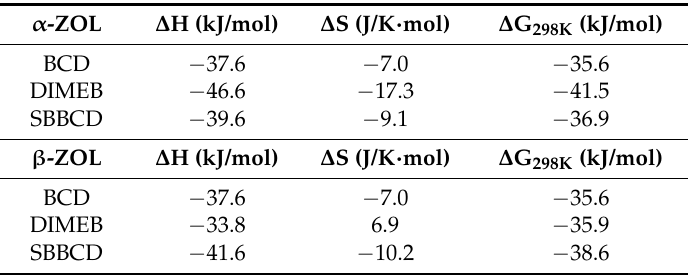
Table 4. Thermodynamic parameters of ZOL-CD interactions without considering the dehydration of the guest molecules prior to the interaction (based on modeling studies). α -ZOL ∆ H (kJ/mol) ∆ S (J/K · mol) ∆ G 298K (kJ/mol) BCD −